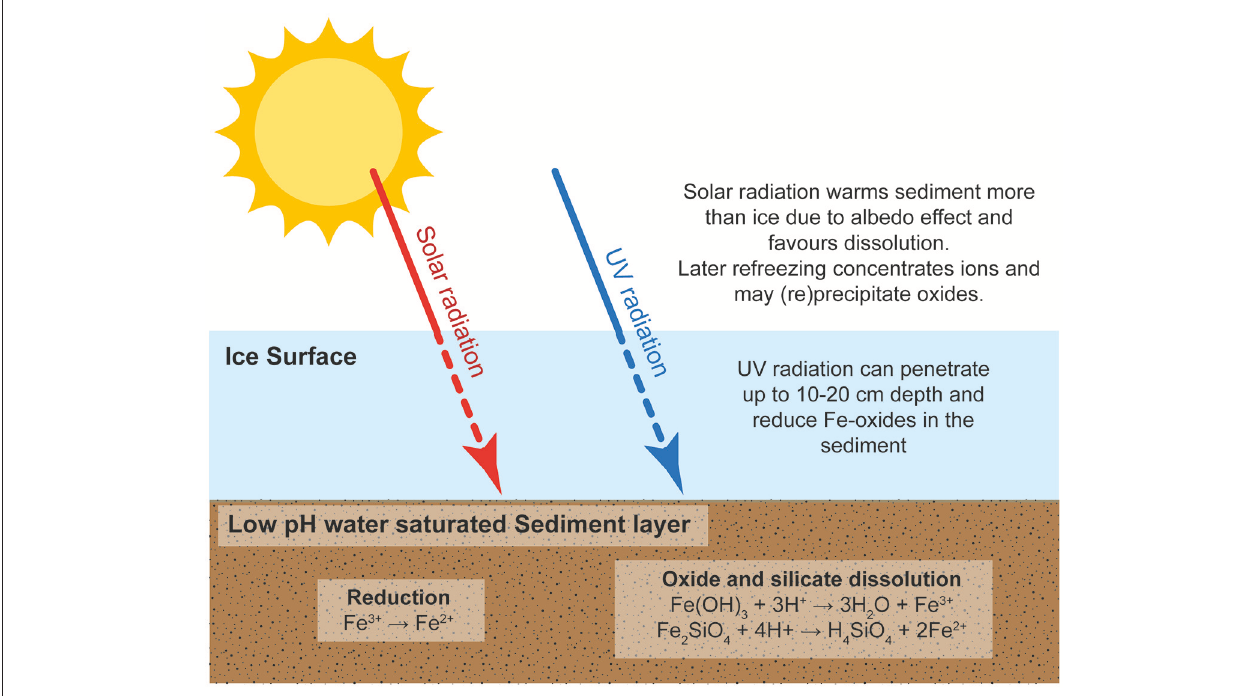
FIGURE 1 | Schematic representation of the redox and dissolution/precipitation cycles that occur in an ice-hosted sediment layer near the ice